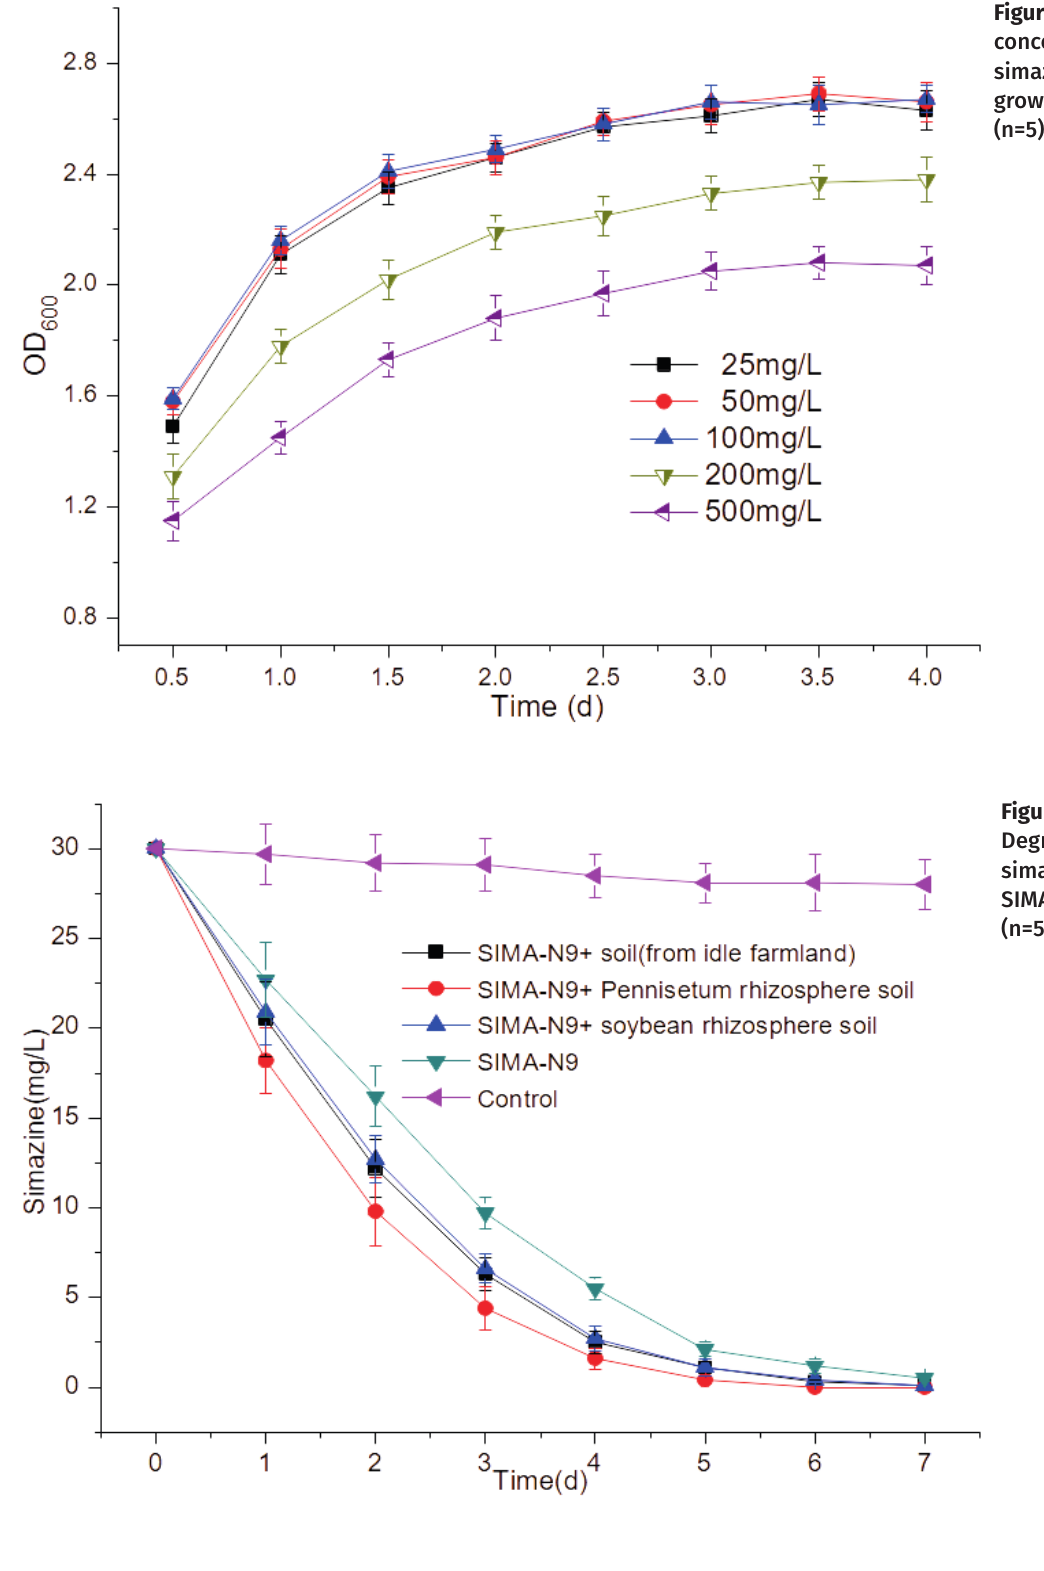
Figure 7. Effect of concentration of simazine on the growth of SIMA-N9 (n=5).